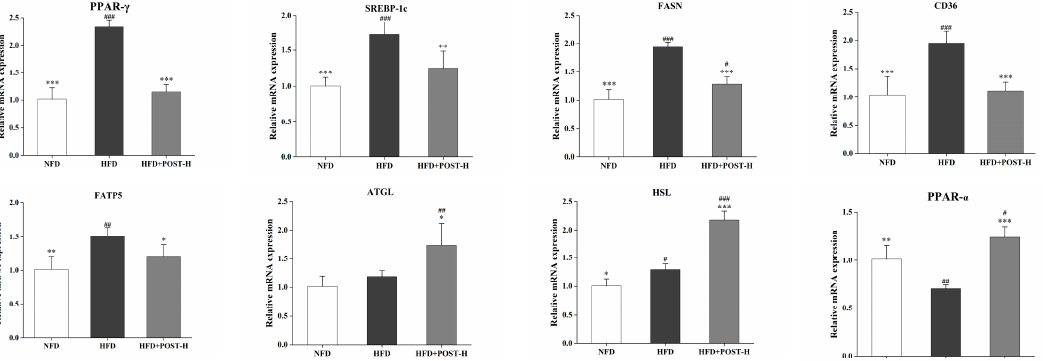
Figure 9. POST regulates hepatic lipid metabolism. Relative mRNA expression of PPAR- γ , SREBP-1c, FASN, CD36, FATP5, ATGL, HSL, and PPAR- α in the liver. Compared to HFD, * p < 0.05, ** p < 0.01, and *** p < 0.001; Compared to NFD, # p < 0.05, ## p < 0.01, and ### p < 0.001.